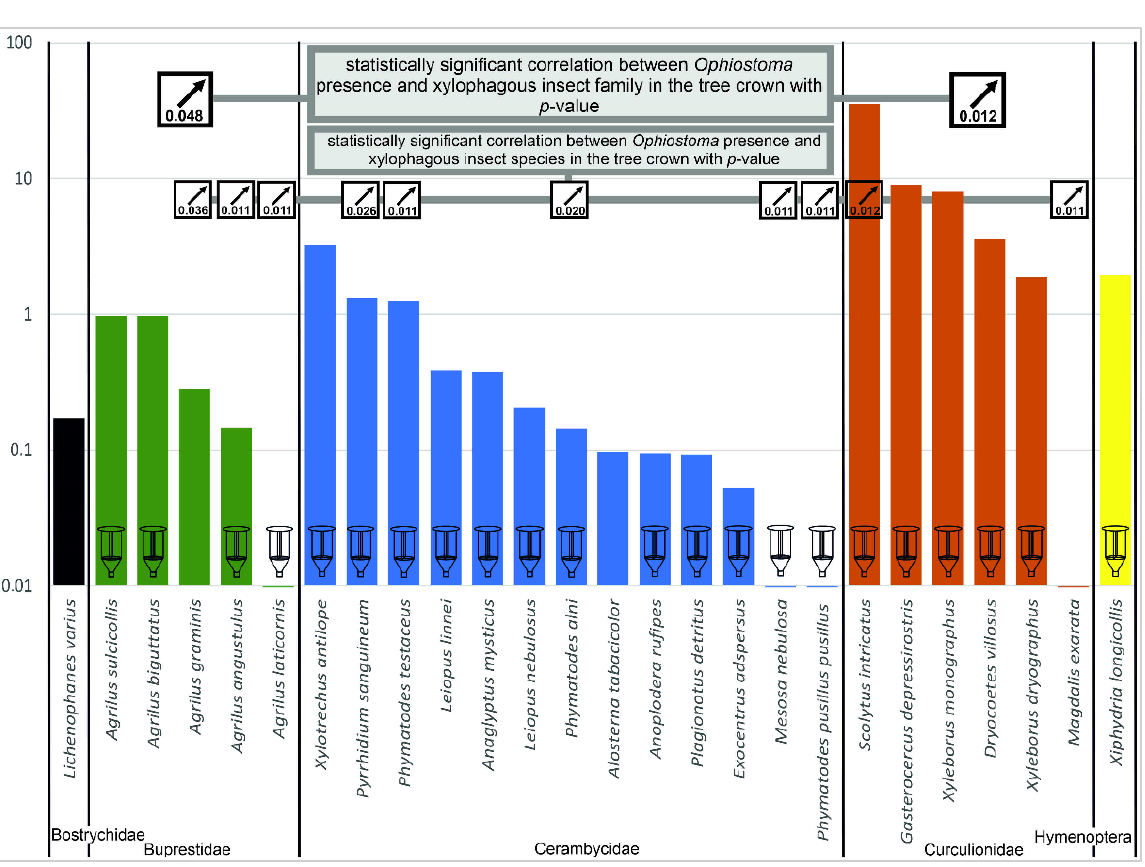
Figure 3. Subcortical insects reared from rearing cages. The individual species are grouped into families. The y -axis represents the logarithmic number of records of each species. Boxes with arrows represent the positive correlation between Ophiostoma presence and subcortical insects (with p -val-ues).